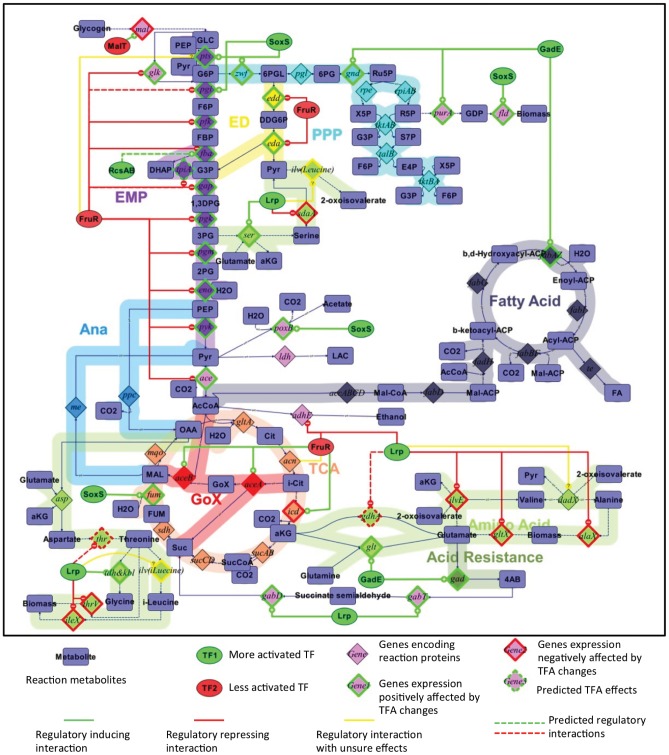
Octanoic acid response network.MG1655 was challenged with sufficient octanoic acid to inhibit growth by 23% (10 mM) in MOPS minimal media at pH 7.0, 37°C, 150 rpm. This diagram shows central metabolism and highlights the regulatory effect of regulators with significantly perturbed activity during C8 challenge, as identified by network component analysis. Dashed lines indicate regulatory connections that were proposed in our previous analysis [30]. Mechanisms for changes in transcription factor activity are discussed in the text.